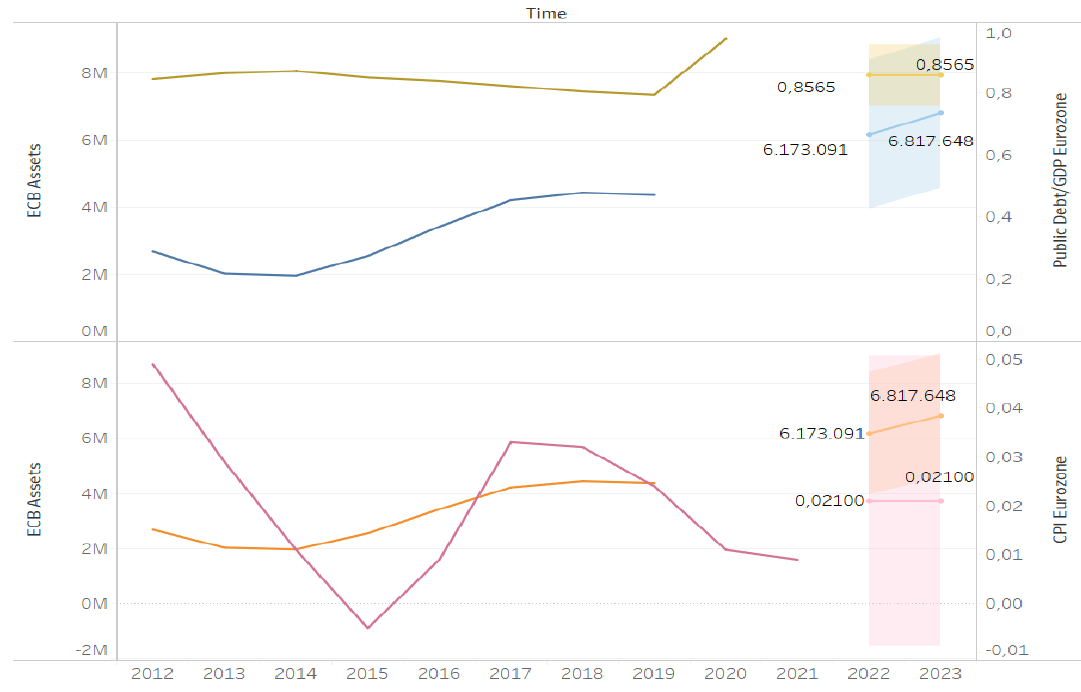
Figure 5. Expansion balance sheet with public debt and CPI (Eurozone). Source: prepared by the authors using Tableau Desktop professional edition and data from the International Monetary Fund, ECB, Fed, and BOJ.